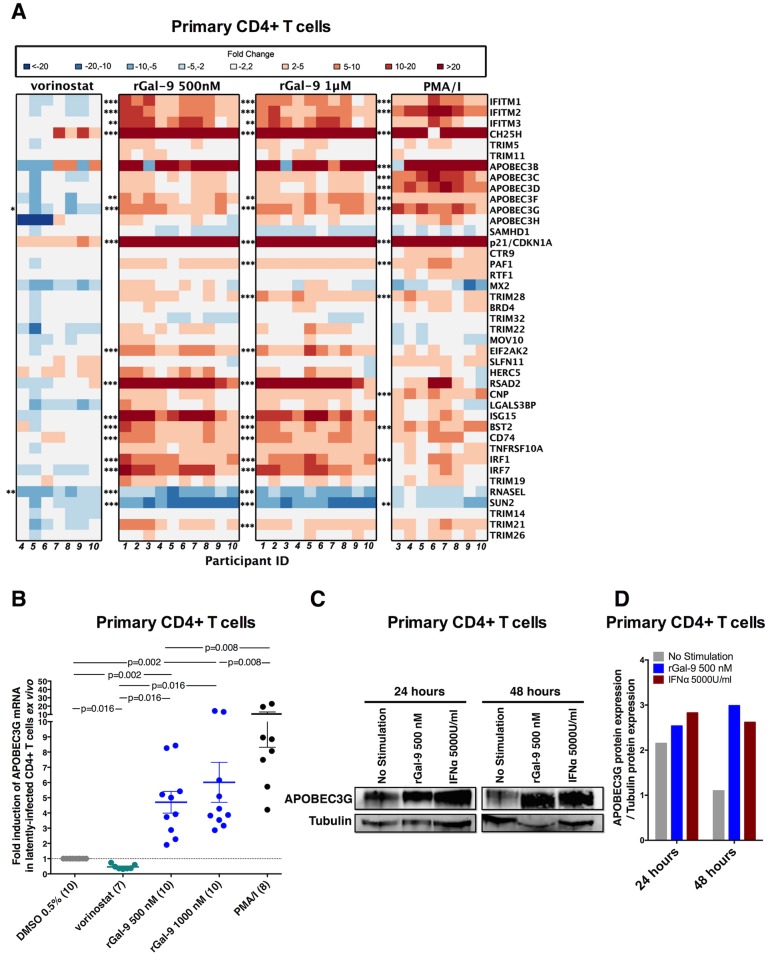
rGal-9 induces the expression of several anti-HIV host restriction factors including APOBEC3G ex vivo.(A) Heat map representing expression levels of host restriction factors in CD4+ T cells isolated from ART-suppressed individuals, after treatment with either 0.5% DMSO as negative control, 500 nM rGal-9, 1000 nM rGal-9, 1μM vorinostat, or a combination of PMA (2 nM) and Ionomycin (0.5 μM). Heat colors indicate fold modulation compared to the DMSO control. Red indicates induction of expression, and blue indicates reduction of expression. Statistical comparisons were performed using t tests, and p values were adjusted for multiple comparisons using false discovery rate. Asterisks indicate >3-fold, statistically significant modulation of gene expression as compared to DMSO control, as follows: * = FDR<0.05; ** = FDR<0.01, and *** = FDR<0.001. (B) APOBEC3G expression in isolated CD4+ T cells from HIV-infected ART-suppressed individuals, treated as described in panel A. Statistical comparisons were performed using two-tailed Wilcoxon signed-rank tests compared to the DMSO-treated control. (C-D) APOBEC3G protein expression in CD4+ T cells treated with either 500 nM rGal-9 or interferon-α (5000 units/ml), as determined by western blot. Immunoblotting bands were quantified with ImageJ software. The quantified APOBEC3G protein expression levels were normalized to corresponding Tubulin protein levels to account for variation in loading.